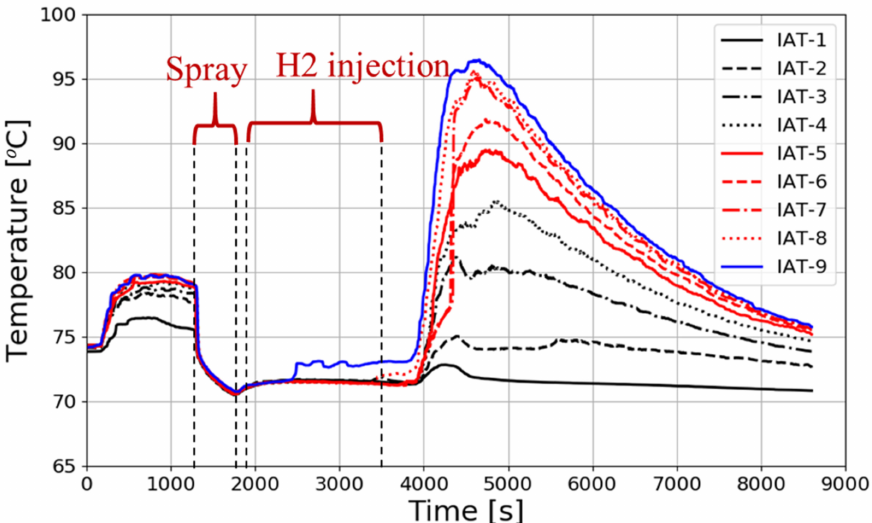
Figure 12. Time variations in the gas temperatures measured during the SSP3 test.